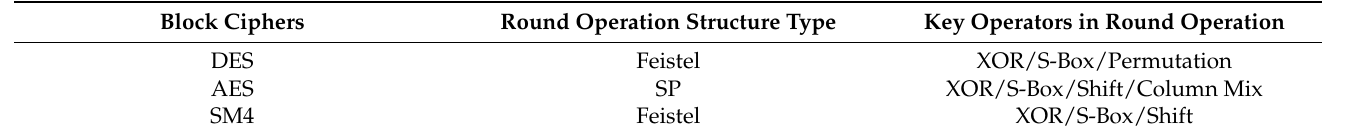
Table 2. Structure types and key operators of round operations in the three major block ciphers.